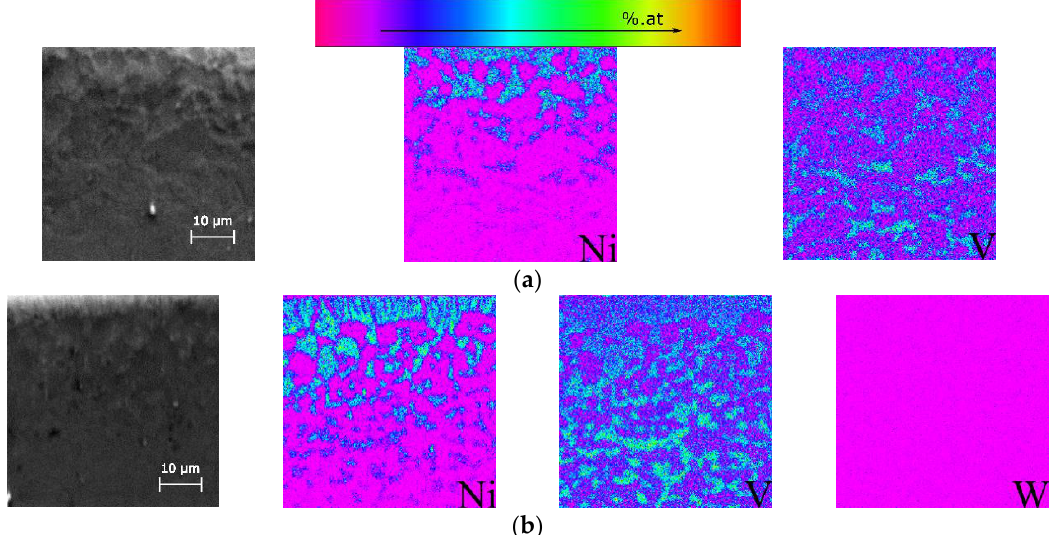
Figure 6. Electron probe microanalysis (EPMA) elemental map distributions of the zone directly under the heat treated Ni/Ti multilayer thin films with 12 nm period ( a ) without or ( b ) with W interlayer.